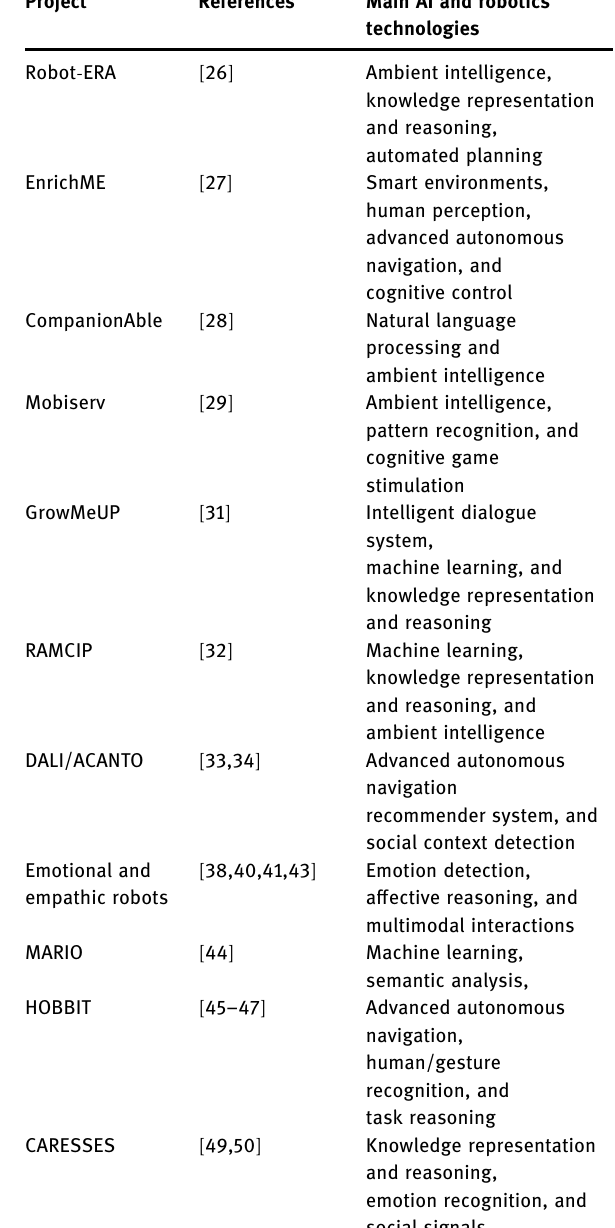
Table 2: Summary from related projects with explicit reference to